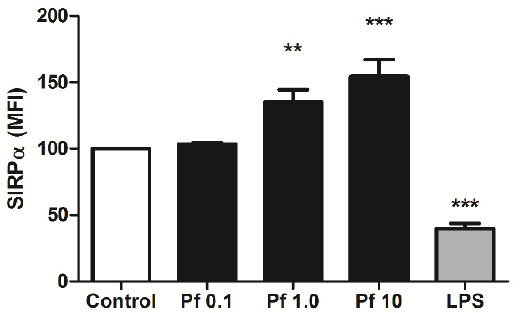
Figure 2. Dose-dependent effect of P. falciparum extract on SIRP α expression. PBMCs from healthy individuals were stimulated for 24 h with crescent concentrations of P. falciparum extract (Pf; 0.1, 1.0 and 10 μ g/mL) or 5 μ g/mL LPS and, the levels of SIRP α expression (MFI) on cell surface of monocyte-like cells was evaluated by flow cytometry, as in Figure 1. Data are shown as mean ± standard error (SEM) and represent one of two independent experiments performed with PBMC samples from five individuals. **: p < 0.01; ***: p < 0.001, as compared with non-stimulated cells (Control).